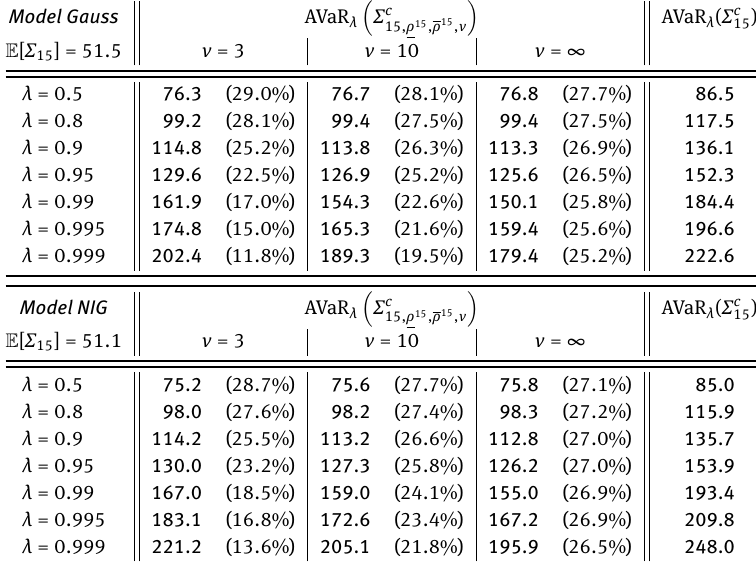
) for ) with the standard comonotonic risk bound AVaR ( Σ c 15 λ 15, ρ 15 , ρ 15 , ν )− E [ Σ 15 ])/(AVaR ( Σ c )− E [ Σ 15 ]) is displayed 15 λ 15, ρ 15 , ρ 15 , ν